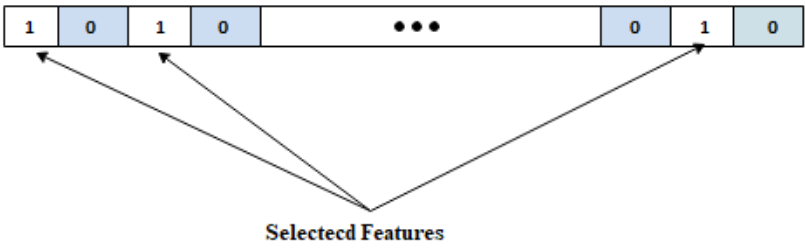
Figure 1. Representation of the search space for all individuals in the population, with an illustration of the binarization procedure of feature indicators for each individual.